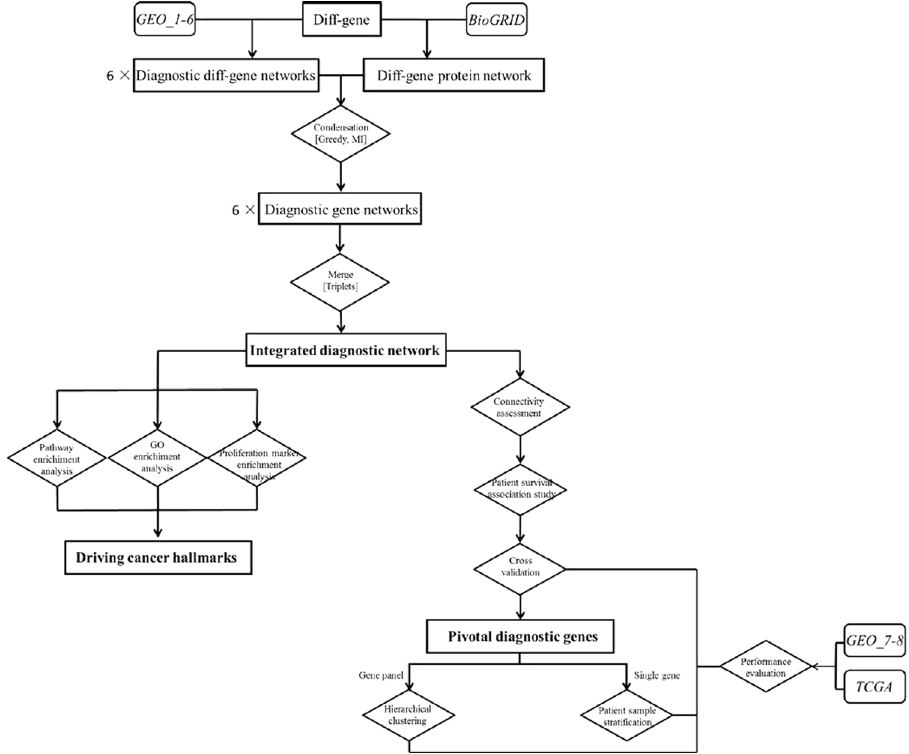
Figure 1. Workflow of this project. Each rounded square box represents one dataset, each square box shows one set of results, and each diamond box illustrates one operation together with associated algorithms. Datasets are shown in italic, where ‘ Data_1-6 ’ represents GSE70947, GSE15852, GSE20711, GSE65212, GSE18229- GPL887, GSE65194, GSE24450, ‘ Data_7-9 ’ represents GSE24450, GSE25055, TCGA, and ‘BioGRID’ means the BioGRID database. The primary outputs are highlighted in bold face, ‘6 × ’ means that 6 sets of networks were generated. Square brackets in each diamond box represent the algorithm or approach used in the operation.